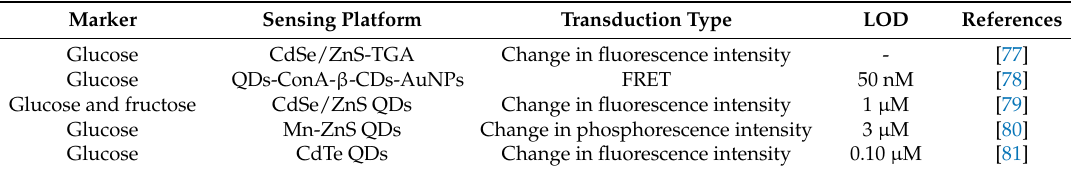
Table 4. QDs-based sensors for sugars